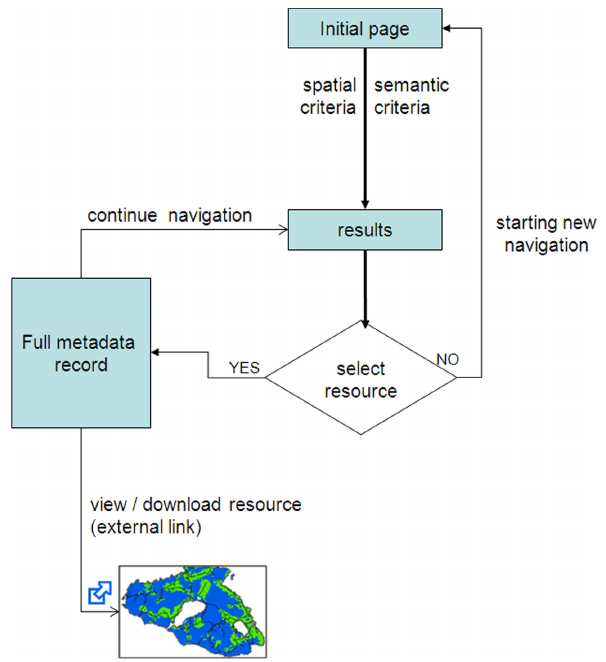
Fig. 4. Information flow in the browsing interface of